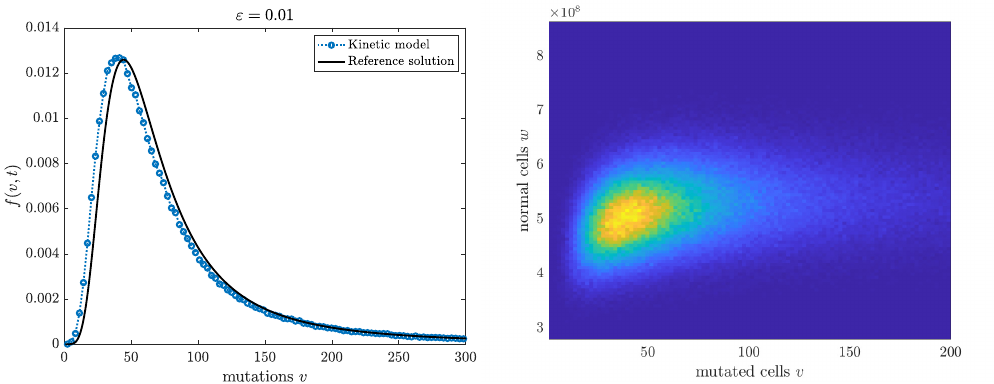
Figure 3. Barlett case. Distribution of mutant cells at T f = 6.7 with β 1 = 3 and β 2 = 2.8 for ε = 0.01 in the kinetic model (47) under scaling (33). Marginal density of mutants ( left ) and full kinetic density ( right ). The reference solution is the same as in Figure